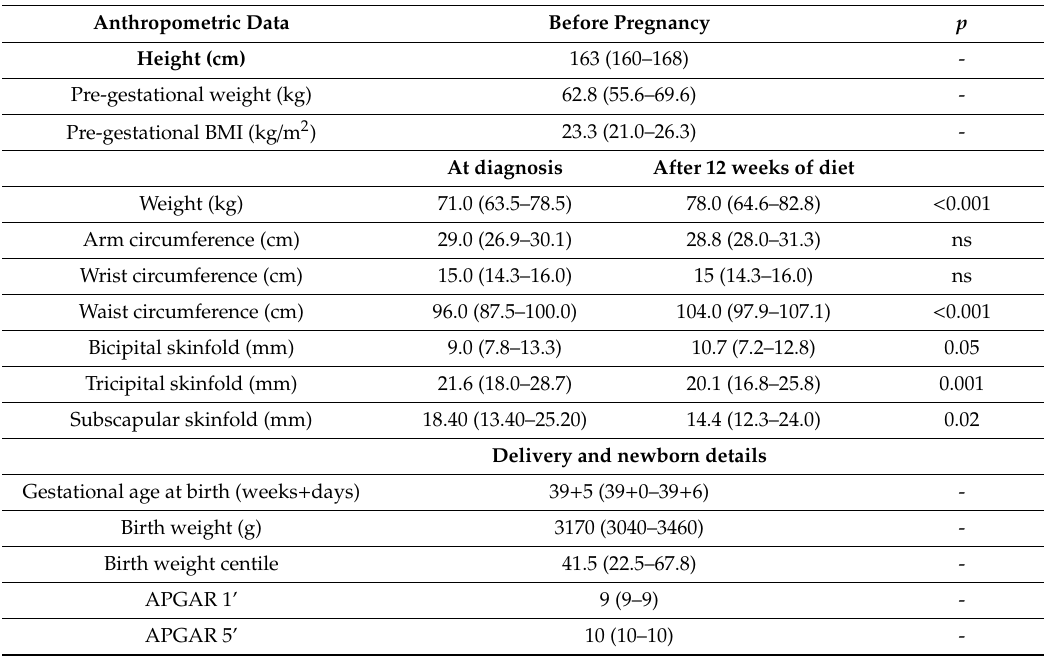
Table 1. Anthropometric data of the enrolled women before and during pregnancy and details related to delivery and